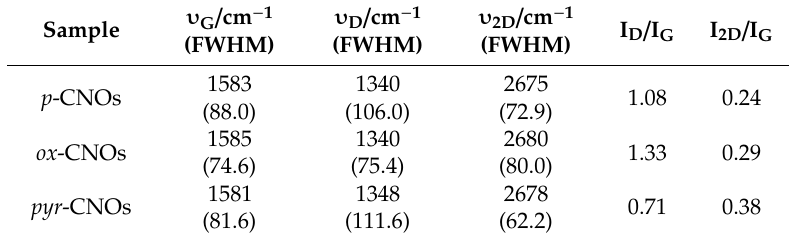
Table 1. D and G band intensity ratios of the functionalized and non-functionalized